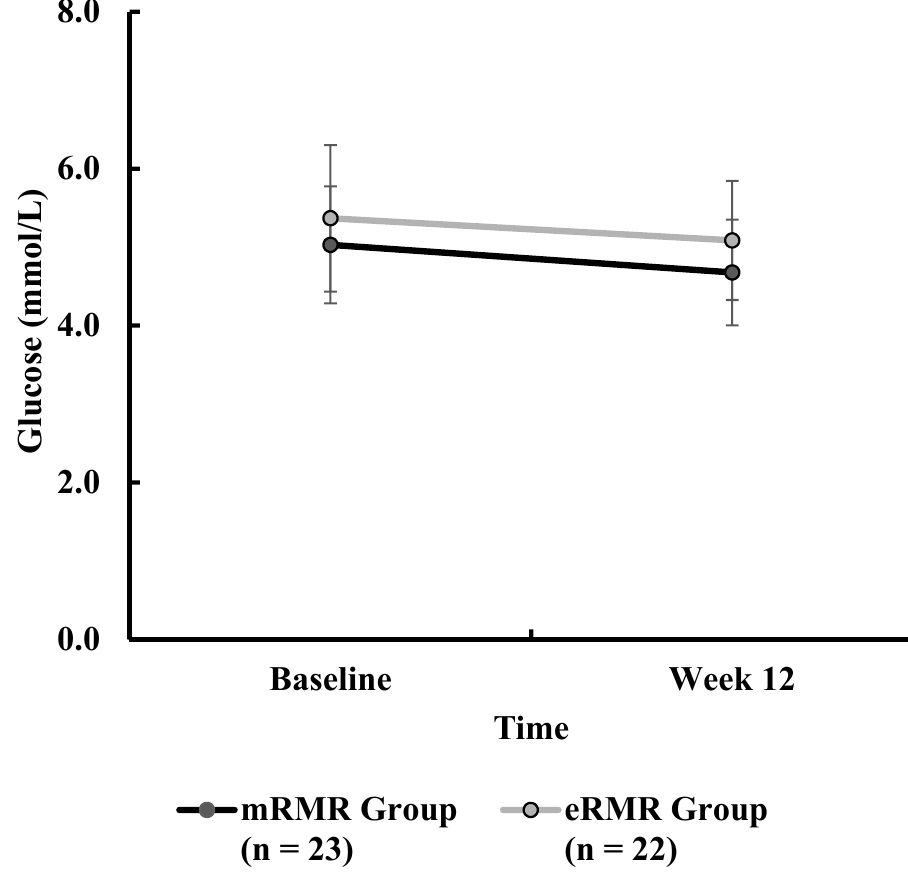
Figure 3. Blood glucose (mmol/L) measured at baseline and week 12 for the mRMR ( n = 23) and eRMR groups ( n = 22). 3.13. Total Cholesterol